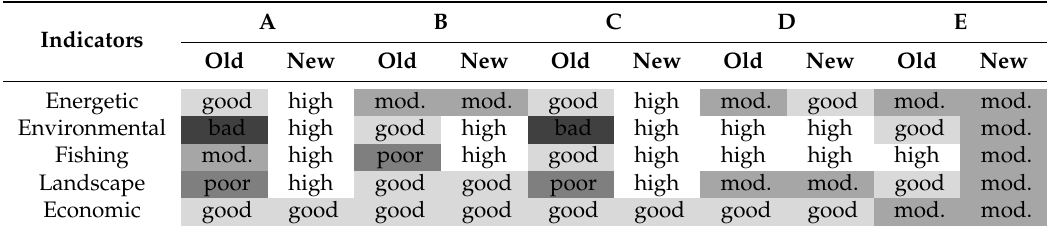
Table 4. An evaluation matrix of stakeholders’ feedback. A comparison between the previous set of indicators (indicated as “old”) and the updated decisional tree (indicated as “new”) was carried out for each of the selected features described in Section 2.5 (i.e., A = reactiveness to flow releases’ variation; B = compliance with the legislative framework; C = compliance with stakeholders’ needs; D = transferabilitytodi ff erentrivercontexts; E = availabledataset). Theword“mod.”istheabbreviation of